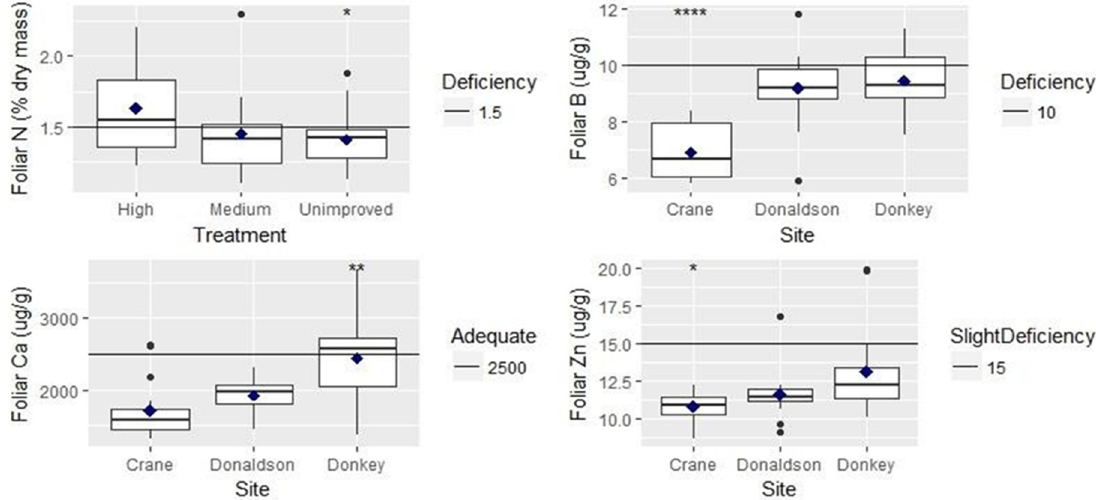
Figure 3. Nutrient deficiency box plots, values as per Edmonds et al. [32].